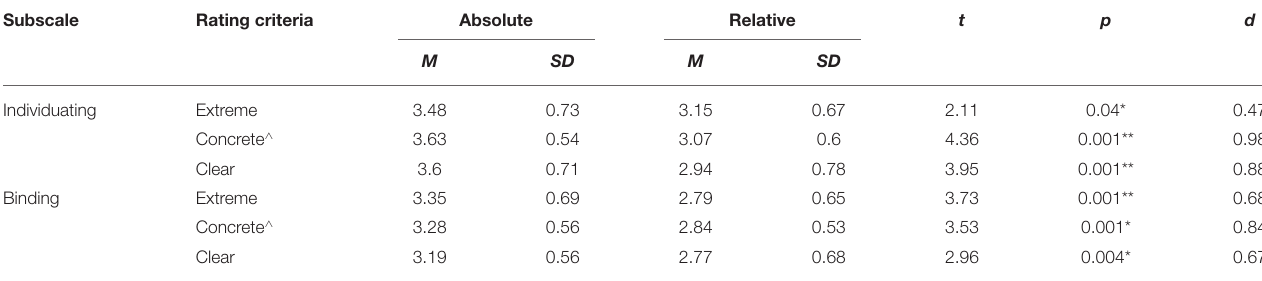
TABLE 1 | Effects of absolute vs. relative framing on dimensions of item wording extremity, concreteness, and clarity.